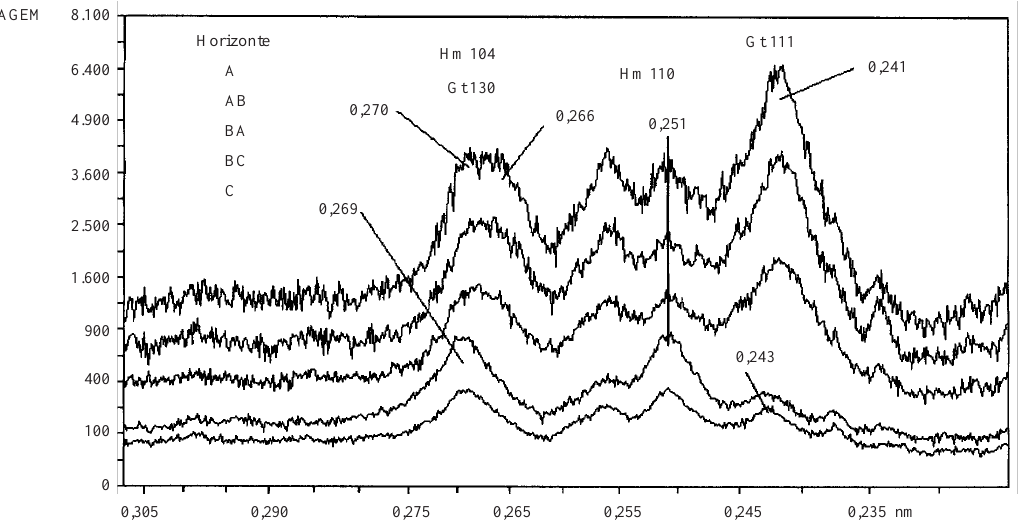
Figura 6. Difratogramas do pó de amostras com o concentrado dos óxidos de ferro, evidenciando a variação na posição dos reflexos da Gt e Gt dos horizontes A, AB e BA em relação aos horizontes BC e C do 111 130 perfil P1. (Gt = goethita; Hm = hematita; An = anatásio; Qt =